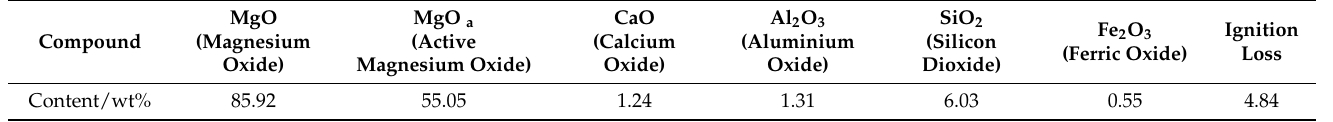
Table 1. The chemical composition of light-burned magnesia